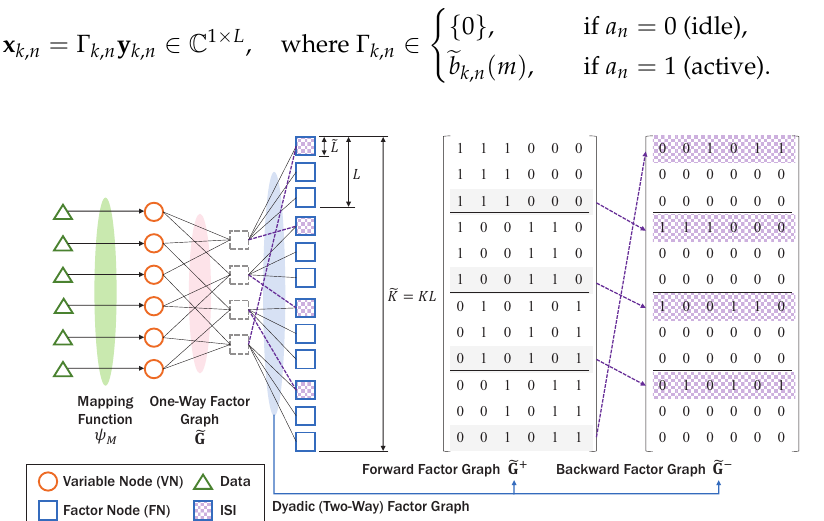
Figure 6. Example of dyadic factor graph composed of forward factor graph (cid:101) G + and backward factor graph (cid:101) G − ( K = 4, N = 6, K 1 = 2, L = 3, (cid:101) L =